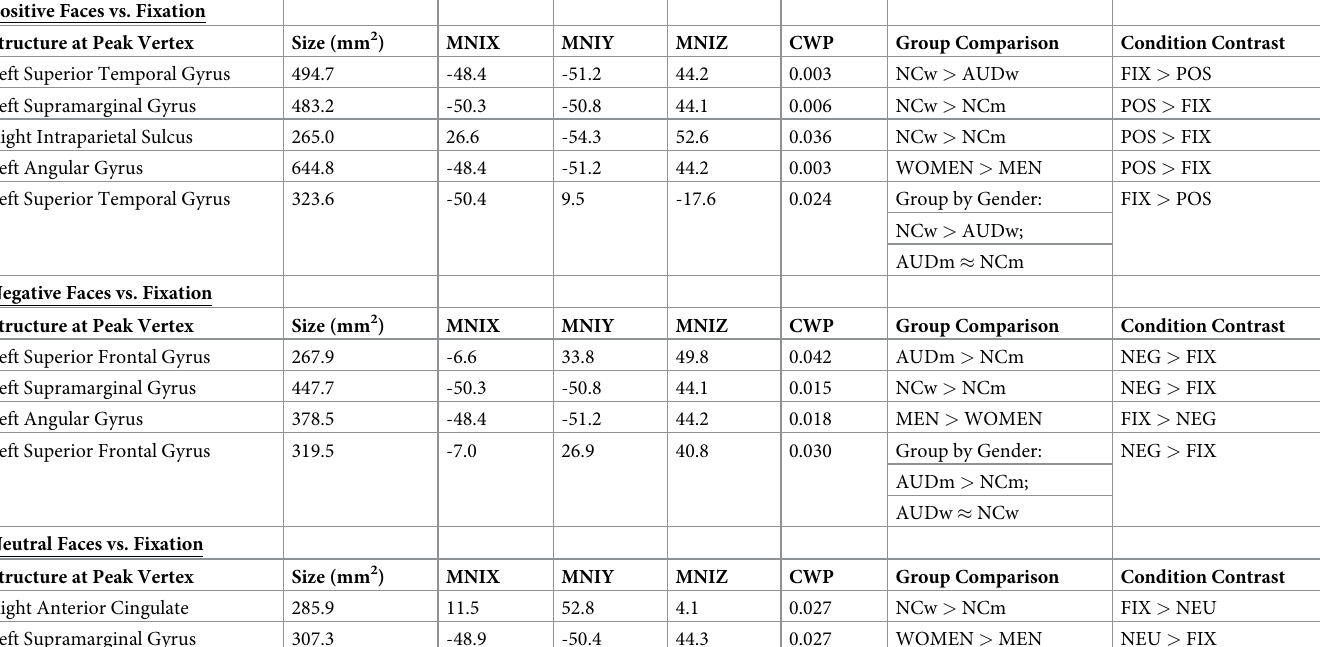
Table 3. Emotion whole brain intergroup cluster analysis: Positive vs. fixation, negative vs. fixation, neutral vs. fixation, positive vs. negative, positive vs. neutral, negative vs. neutral. Positive Faces vs. Fixation